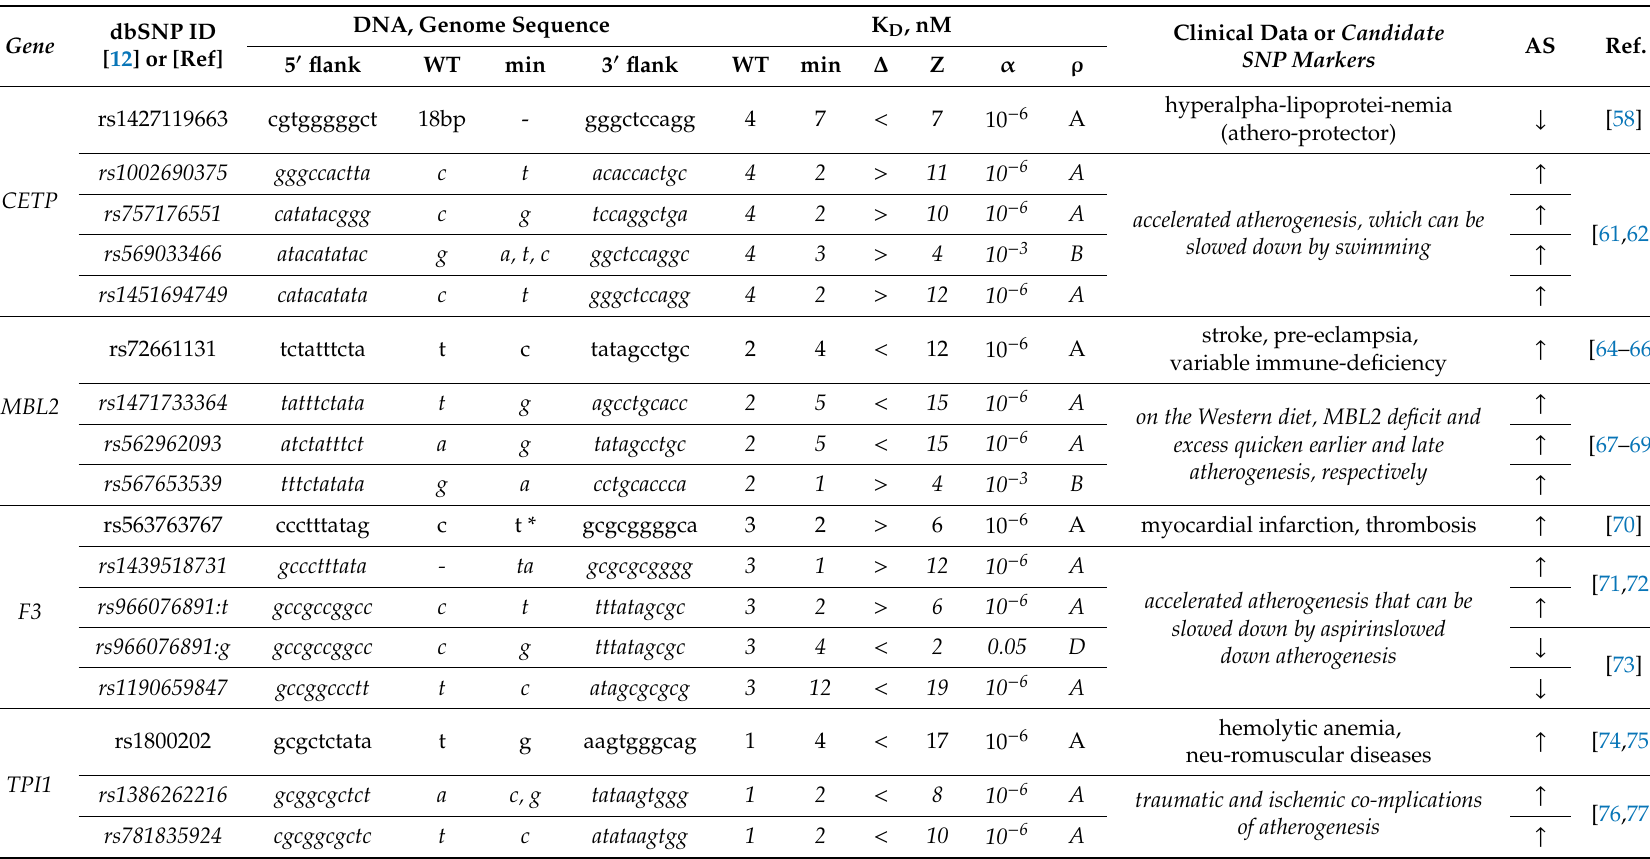
Table 2. Atherogenesis-related candidate SNP markers within the gene promoters where SNPs of TBP-sites are clinically linked with cardiovascular diseases.